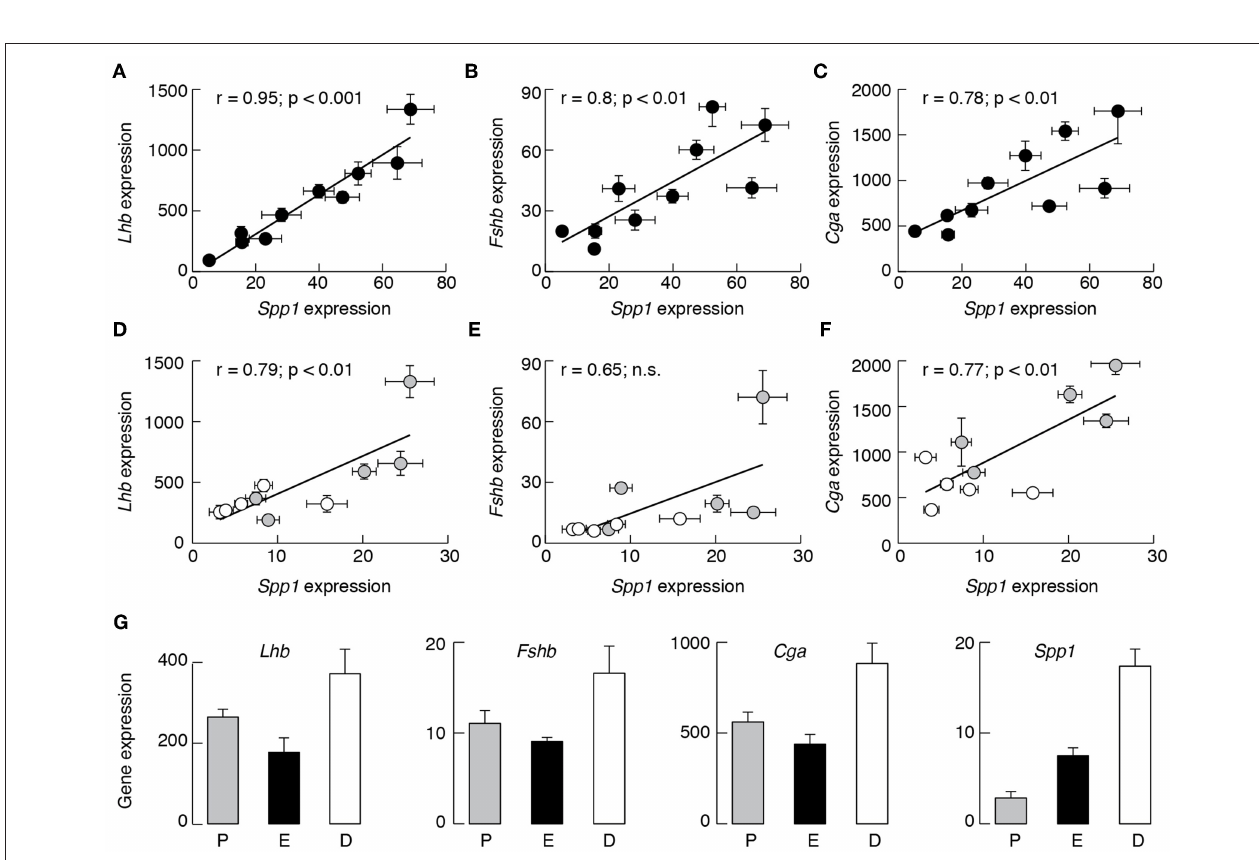
FIGURE 2 | The expression of Spp1 correlates with expression of other gonadotroph marker genes in a sex-specific manner in anterior pituitary tissue from developing rats. Correlation between Spp1 vs. Lhb (A,D) , Fshb (B,E) , and Cga (C,F) expression. Data points for Lhb , Fshb , and Cga are derived from (35). n.s., non-significant. Gray circles, prepubertal females; white circles, postpubertal females. (G) The expression of gonadotroph marker genes and Spp1 in postpubertal females during estrous cycle: P, proestrus; E, estrus; D, diestrus-1 (metestrus) + diestrus-2.